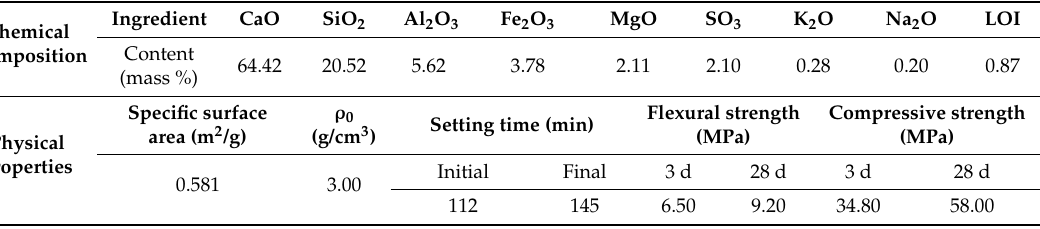
Table 1. Chemical composition and physical properties of OPC.